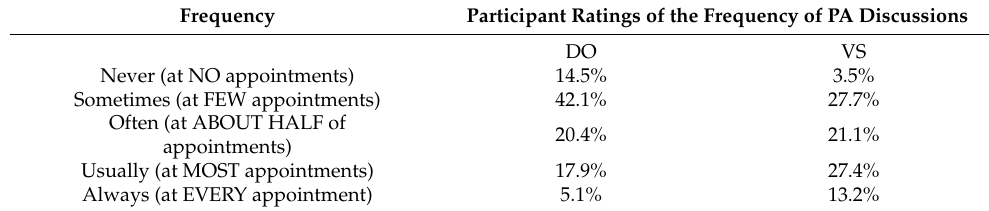
Table 3. Dog owner (DO; n = 1028) and veterinary staff (VS; n = 722) ratings of the frequency with which PA is discussed during veterinary visits.